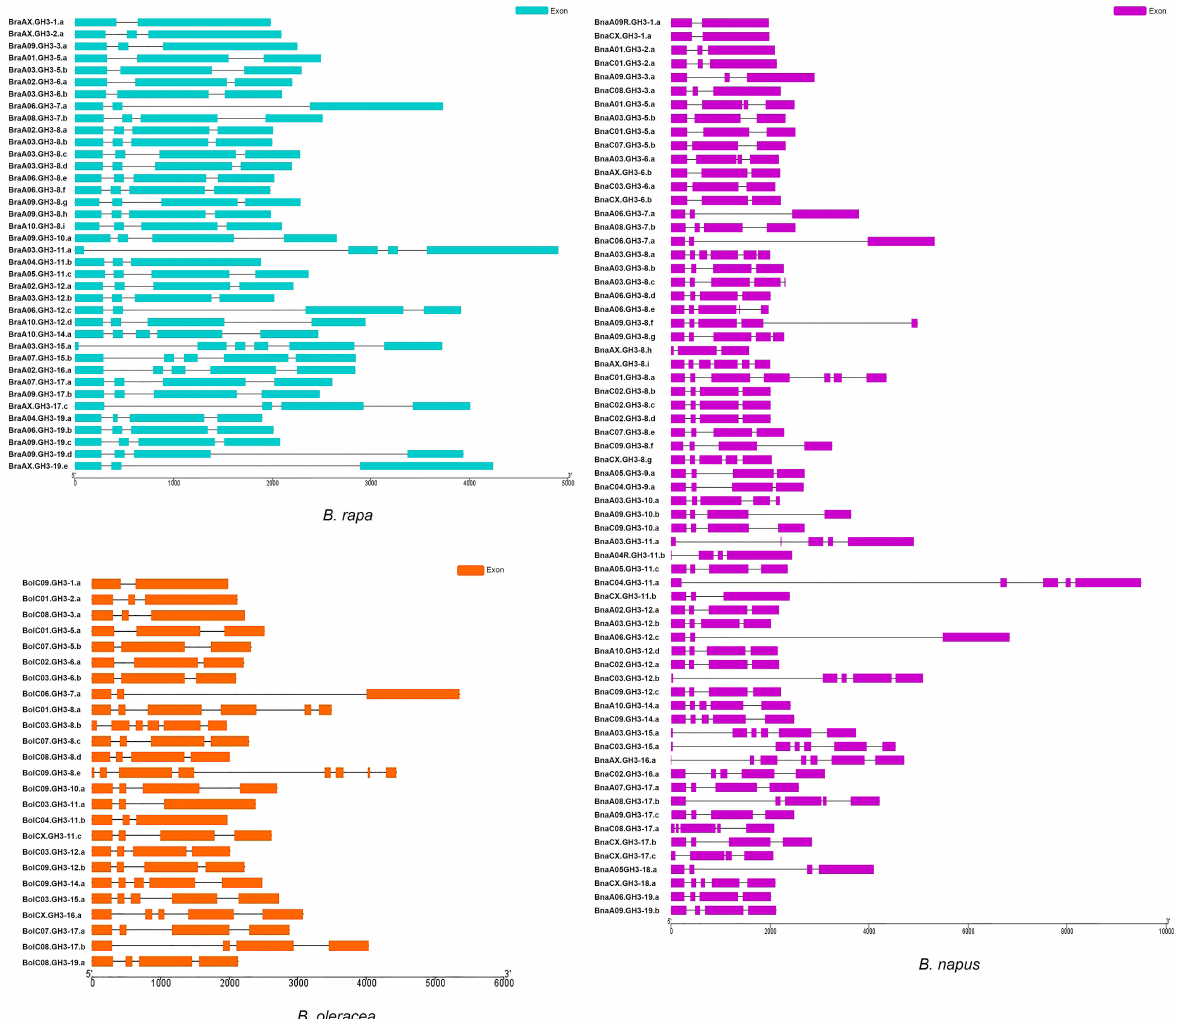
Figure 4. The exon–intron compositions of GH3 genes in the three species of Brassica